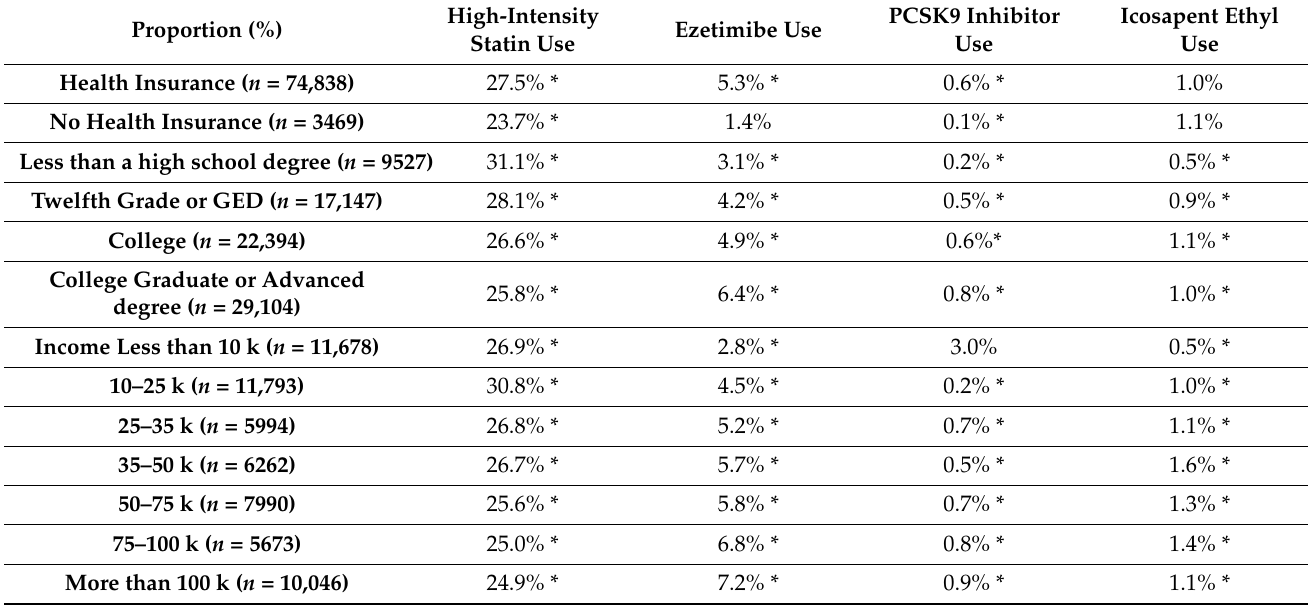
Table 3. Prevalence of high-intensity statin, ezetimibe, PCSK9 inhibitor, and icosapent ethyl treat- ments in Adults with DM across health insurance, education, and income.